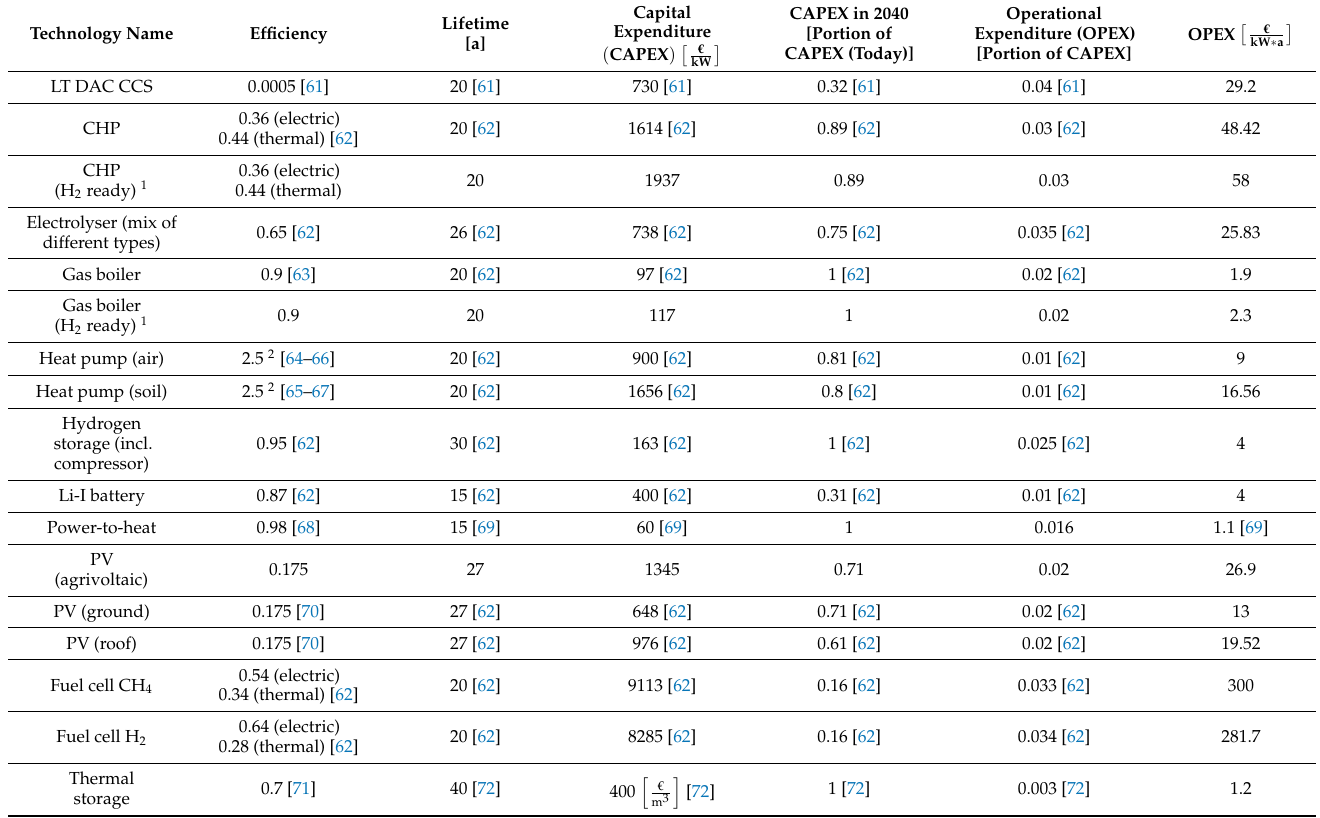
Table 1. Assumed techno-economic parameters.